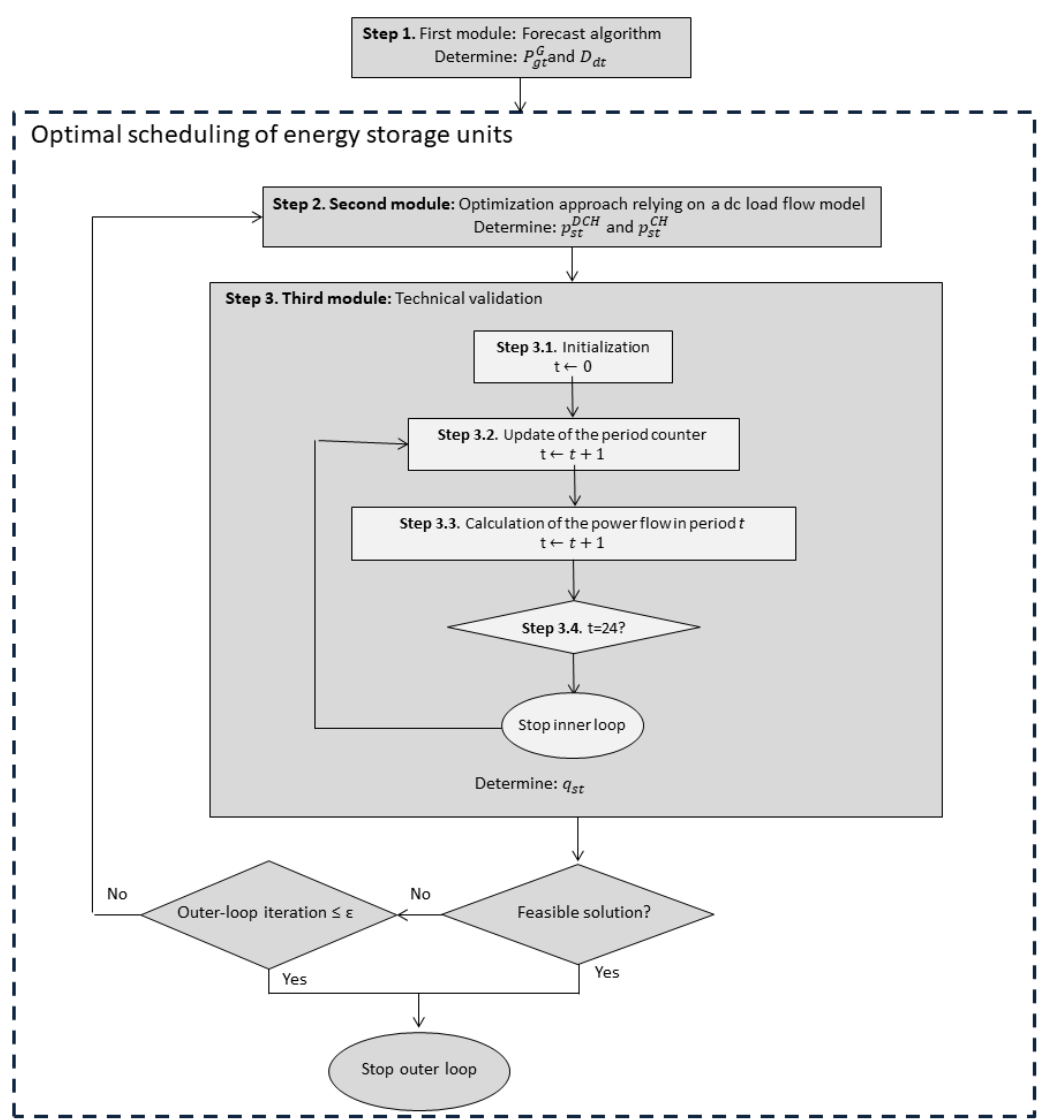
Figure 1. Flowchart of the solution methodology.